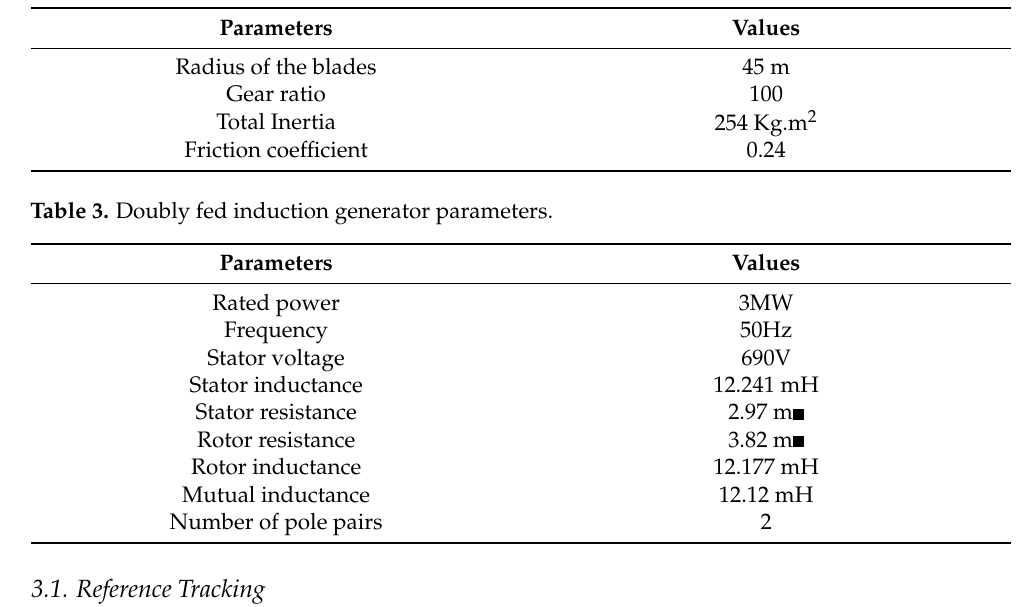
Table 2. Wind turbine parameters.